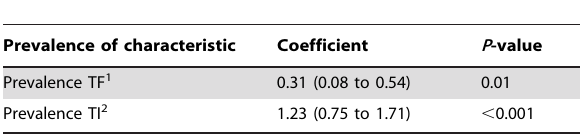
Table 5. Multivariate analysis of clinical trachoma as a predictor of chlamydia infection in children 0–5